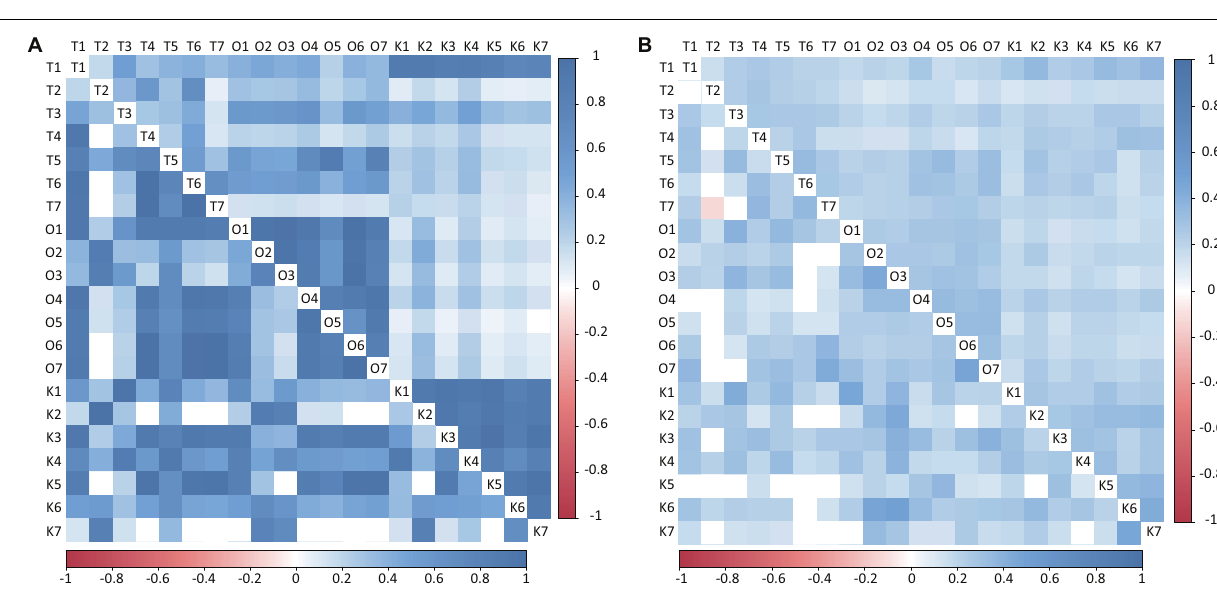
FIGURE 4 | Heatmap of Pearson’s correlation between Endozoicomonas and Acinetobacter among different sampling time from Kochi, Okinawa, and Taiwan. (A) matrix with log transformation. (B) matrix with present/absent transformation. The values above the diagonal represented Endoizoicomonas abundance correlation values and below the diagonal represented Acinetobacter abundance